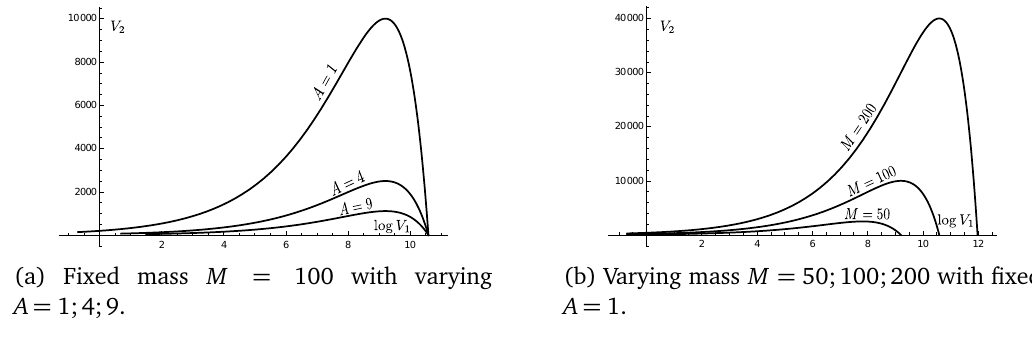
) . The , V 1 2 = 0, V (cid:54) = 0. The 2 1